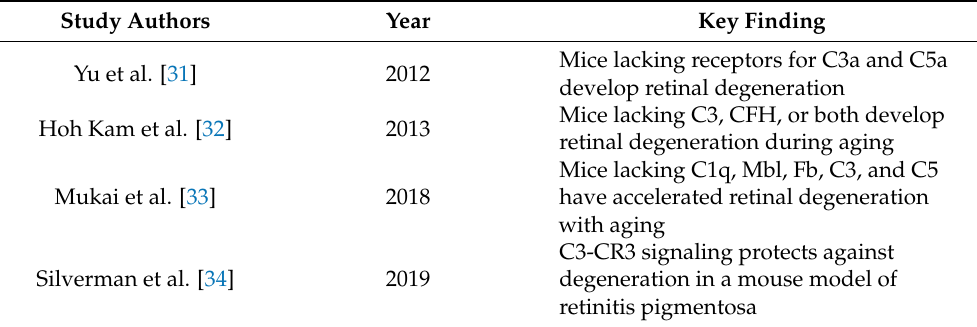
Table 2. Selected basic science studies identifying key role of complement in retinal homeostasis in mouse models.